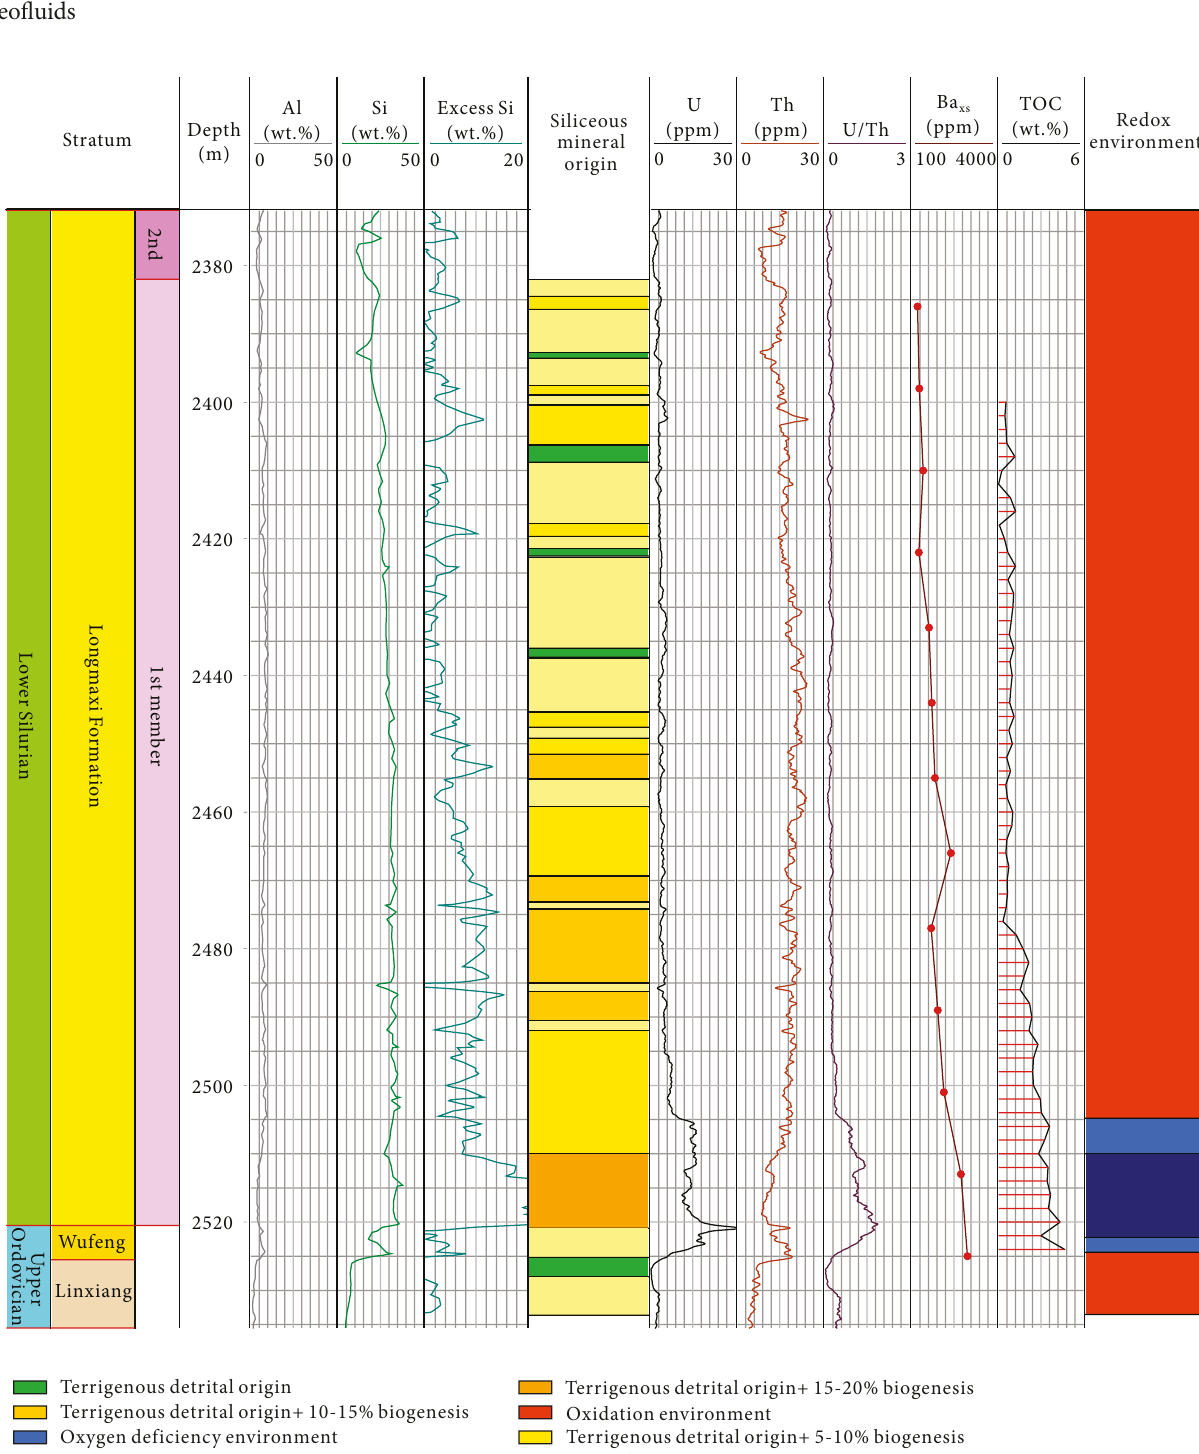
) and TOC content of the upper Ordovician xs